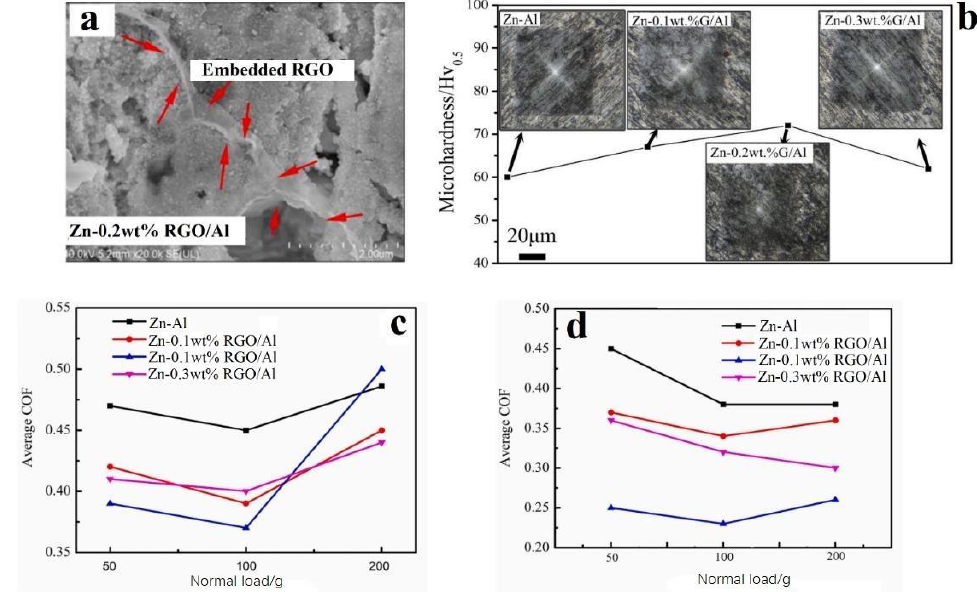
Figure 7. ( a ): SEM image of CS Zn/RGO/Al composite coating showing embedding of the RGO within the coating, ( b ) microhardness trends with varying RGO content, ( c ) average COF of the CS composite coatings in air, and ( d ) average COF of the CS composite coatings in NaCl. Presented with permission from [69].